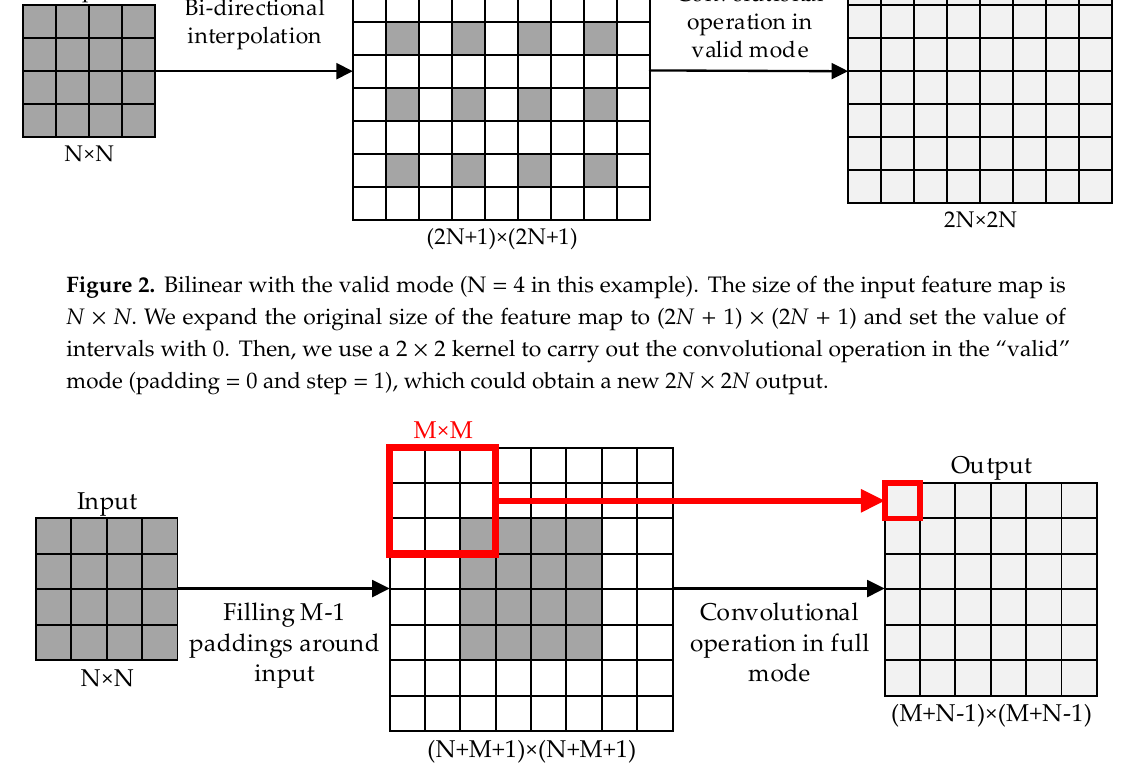
Figure 3. De-convolution with the full mode (N = 4, M = 3 in this example). The size of the input feature map is N × N . We expand the original feature maps with M − 1 paddings (padding pixel = 0) around. Then, we use an M × M kernel to carry out the convolutional operation with the “full” mode (padding = M − 1 and step = 1), which could obtain an ( M + N − 1) × ( M + N − 1) output.